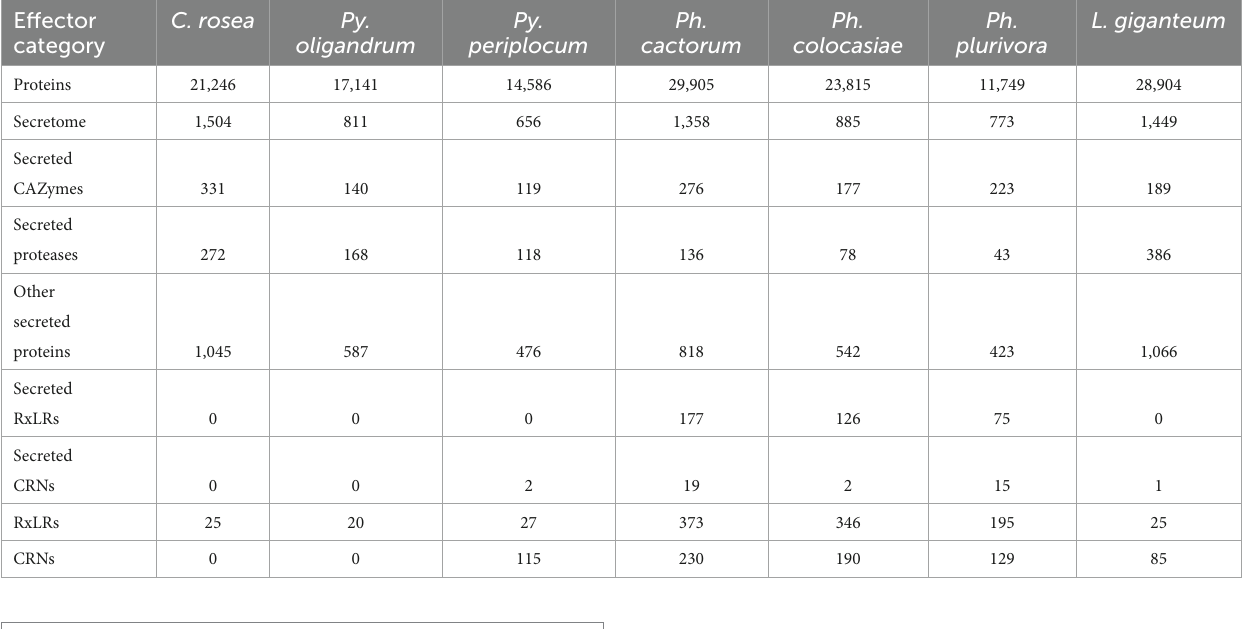
TABLE 2 Number of putative secreted proteins, including effectors, predicted in fungal and oomycete species analyzed in this study. Effector category